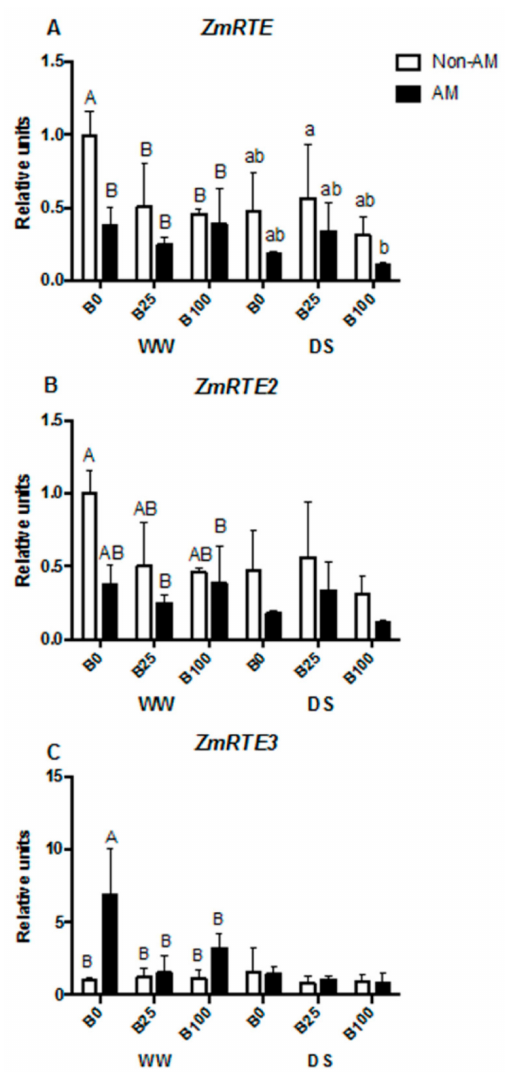
Figure 5. Relative mRNA levels of ZmRTE ( A ) , ZmRTE2 ( B ) and ZmRTE3 ( C ) normalized to ZmEF1 gene. Plants were inoculated or not with the AM fungus R. irregularis , grown under di ff erent B concentrations (0, 25 or 100 µ M B) and submitted to two water regimes (well-watered [WW] or drought stress [DS]). Data indicate the mean ± SE for three biological replicates. Di ff erent letters indicate significant di ff erences between treatments ( p < 0.05) based on Duncan’s